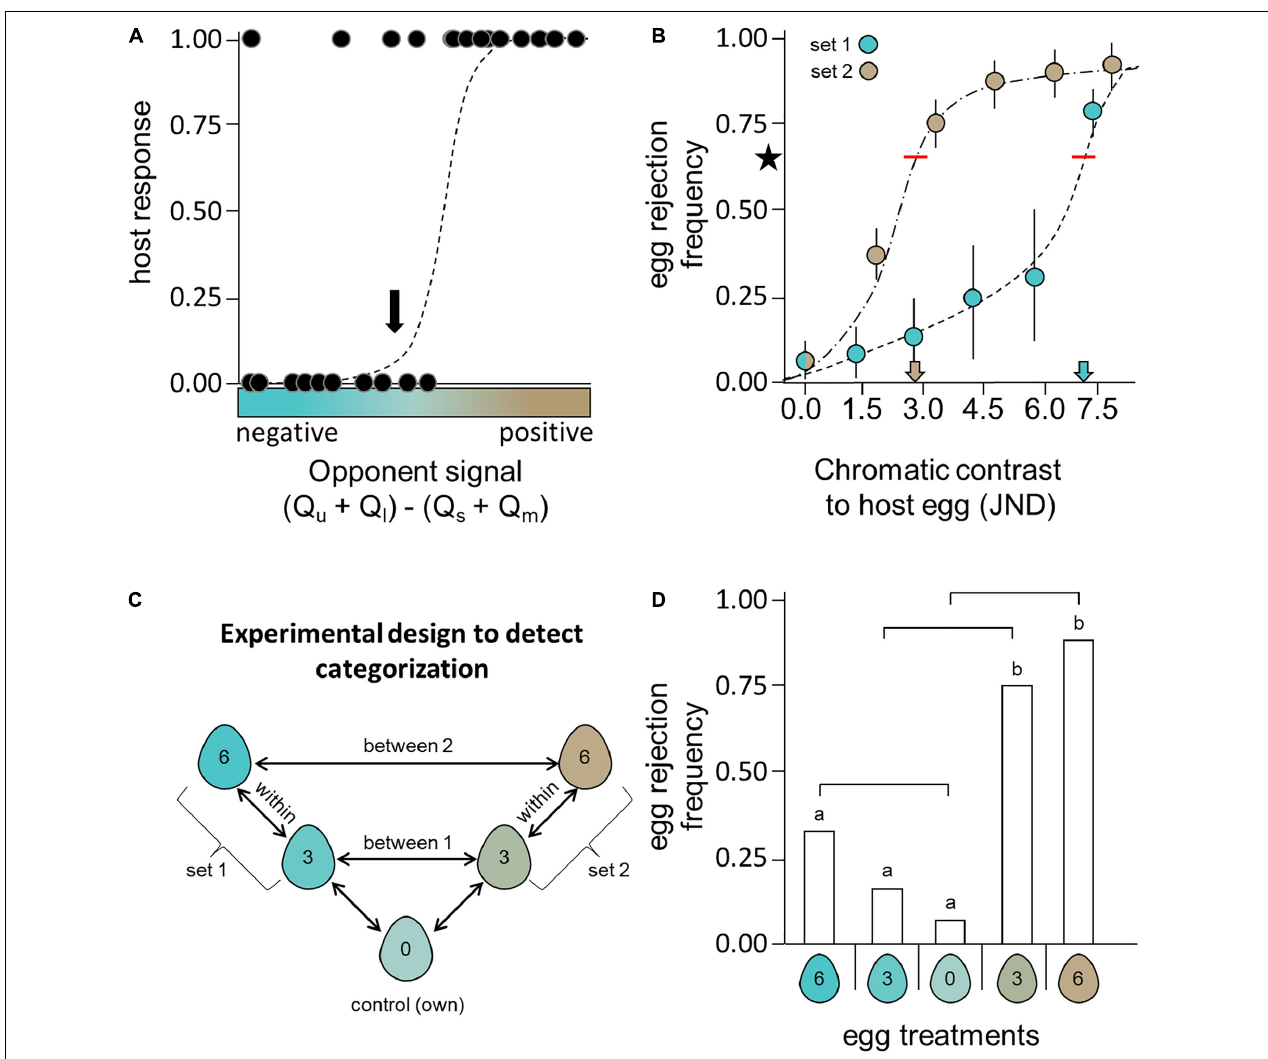
FIGURE 2 | Here we illustrate expected results from an experiment (A) investigating host response to eggs (acceptance = 0, rejection = 1) painted colors ranging from bluer (negative) to browner (positive) than the hosts’ own eggs (solid line on x axis). Egg stimuli are plotted by their opponent channel